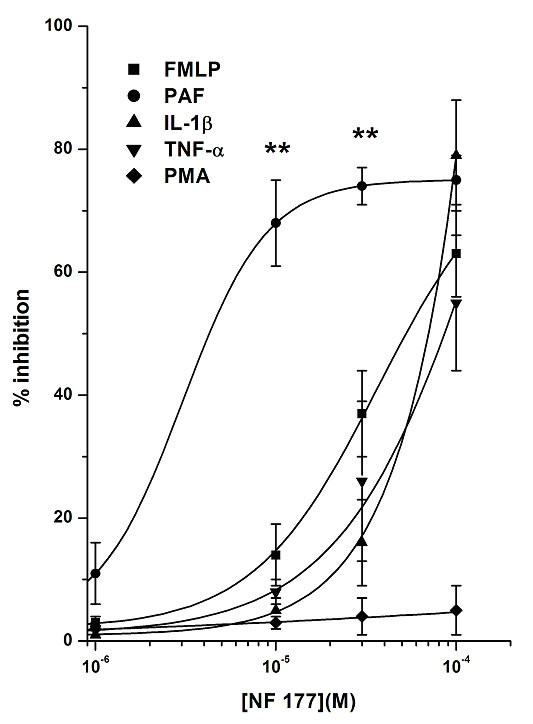
Effects of NF177 on PMN adhesion to HUVEC evoked by PAF, FMLP, IL-1β, TNF-α and PMA. HUVEC were pretreated with increasing concentrations (10-6–10-4M) of the tested compound for 10 min at 37°C and then challenged with PAF, FMLP (both at 10-7M) or PMA (10-8M) and PMNs for a further 10 min; IL-1β and TNF-α (both at 10 ng/ml) were incubated for 1 h with the pretreated HUVEC and then challenged with PMNs for a further 10 min. Data are expressed as percentage inhibition versus control adhesion. PAF, FMLP, IL-1β, PMA and TNF-α stimulation vs control was, respectively: 305 ± 37%, 283 ± 28%, 270 ± 23%, 340 ± 46% and 304 ± 29%. Data are expressed as means ± SEM; n = 5. IC50 values were: 1.7 ± 0.6 × 10-6M, 2.6 ± 0.5 × 10-5M, 9.4 ± 0.4 × 10-5M and 3.9 ± 0.5 × 10-5M when the stimulus used was PAF, FMLP, IL-1β and TNF-α, respectively. IC50 values obtained with PAF were statistically different from all others (P < 0.01). Asterisks mark statistically significant inhibition of NF177 using PAF as stimulus versus all other stimuli (**P < 0.01).